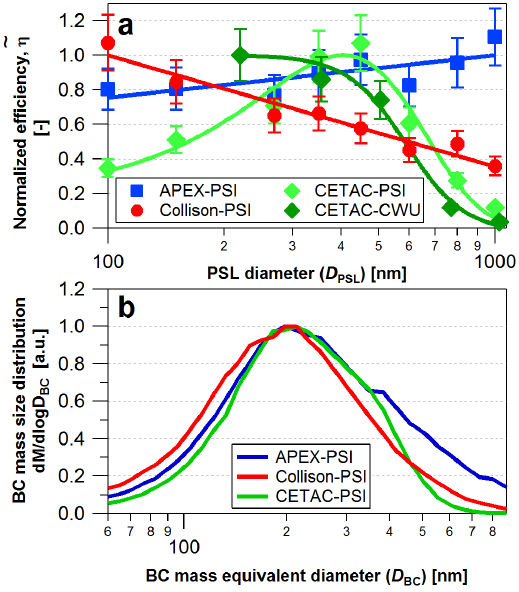
Figure 1. Comparison of the nebulizer efficiencies for the three dif- ferent setups (CETAC, Apex Q and Collison-type nebulizer) for par- ticle diameters from 100 to ∼ 1000nm. (a) Nebulizer efficiency for PSL standards of known number concentration; curves normalized to their maximum. (b) BC mass size distribution of polydisperse Aquadag as measured in the three setups; curves normalized to their maximum. a.u. stands for arbitrary